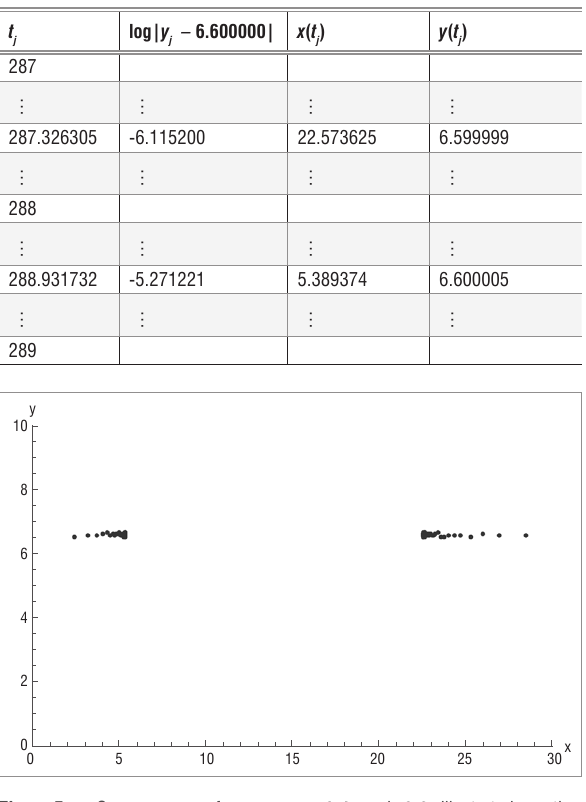
} and { v } illustrated on the j j